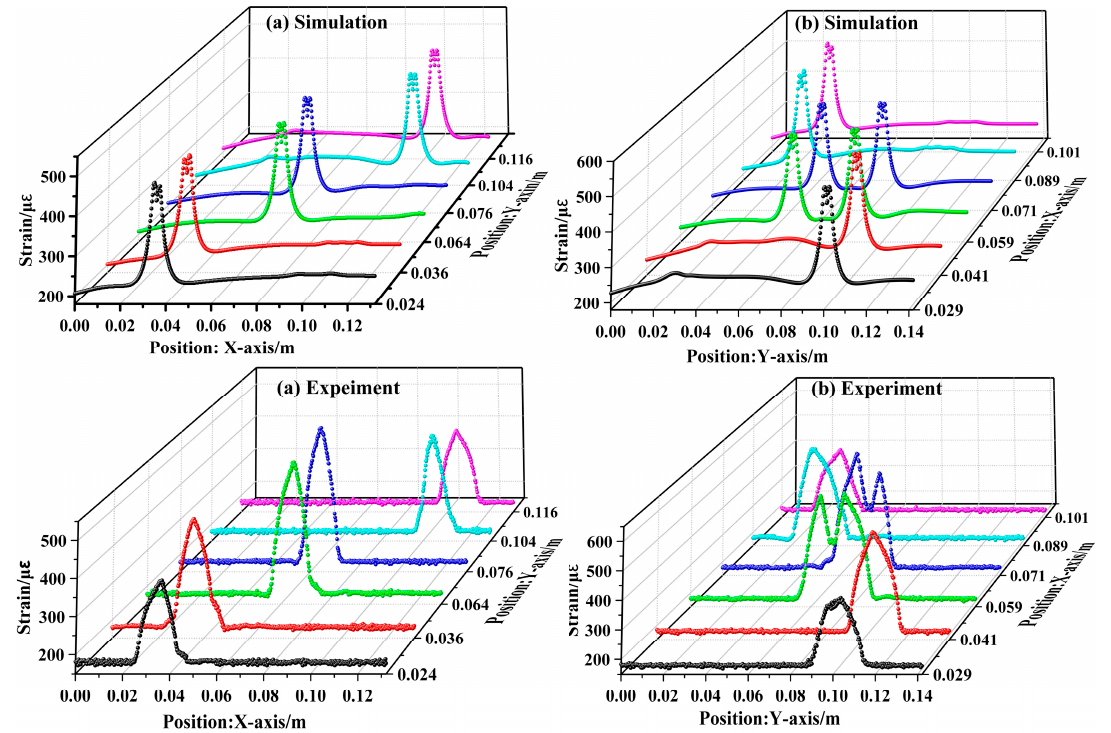
Figure 9. Multiple–crack sensing with 5 kN load applied along ( a ) the x -axis and ( b ) the y -axis.